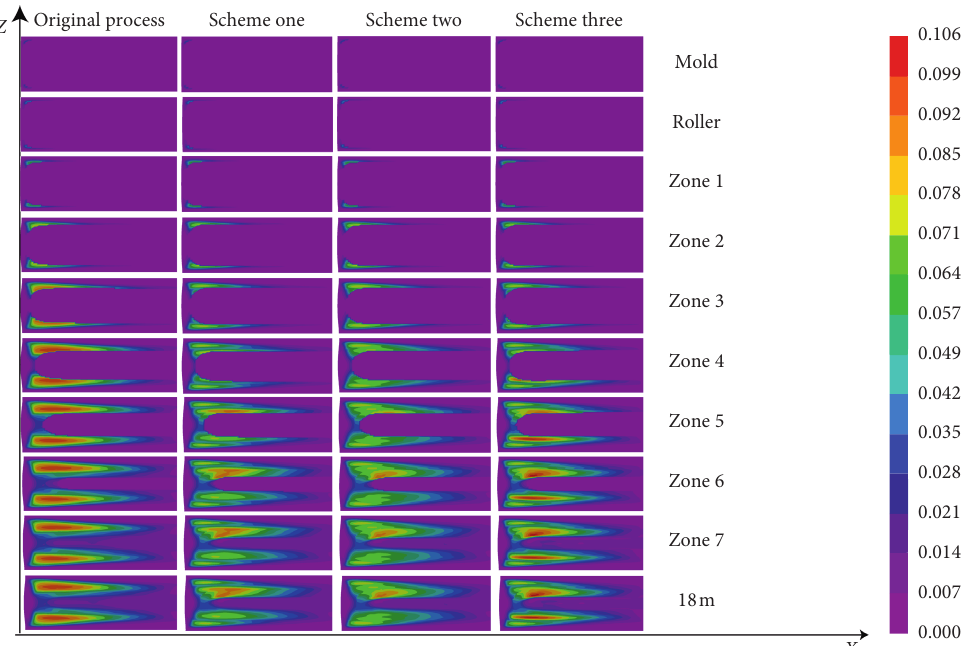
Figure 18: Hot-tearing distribution at the outlet of each zone under different water distribution